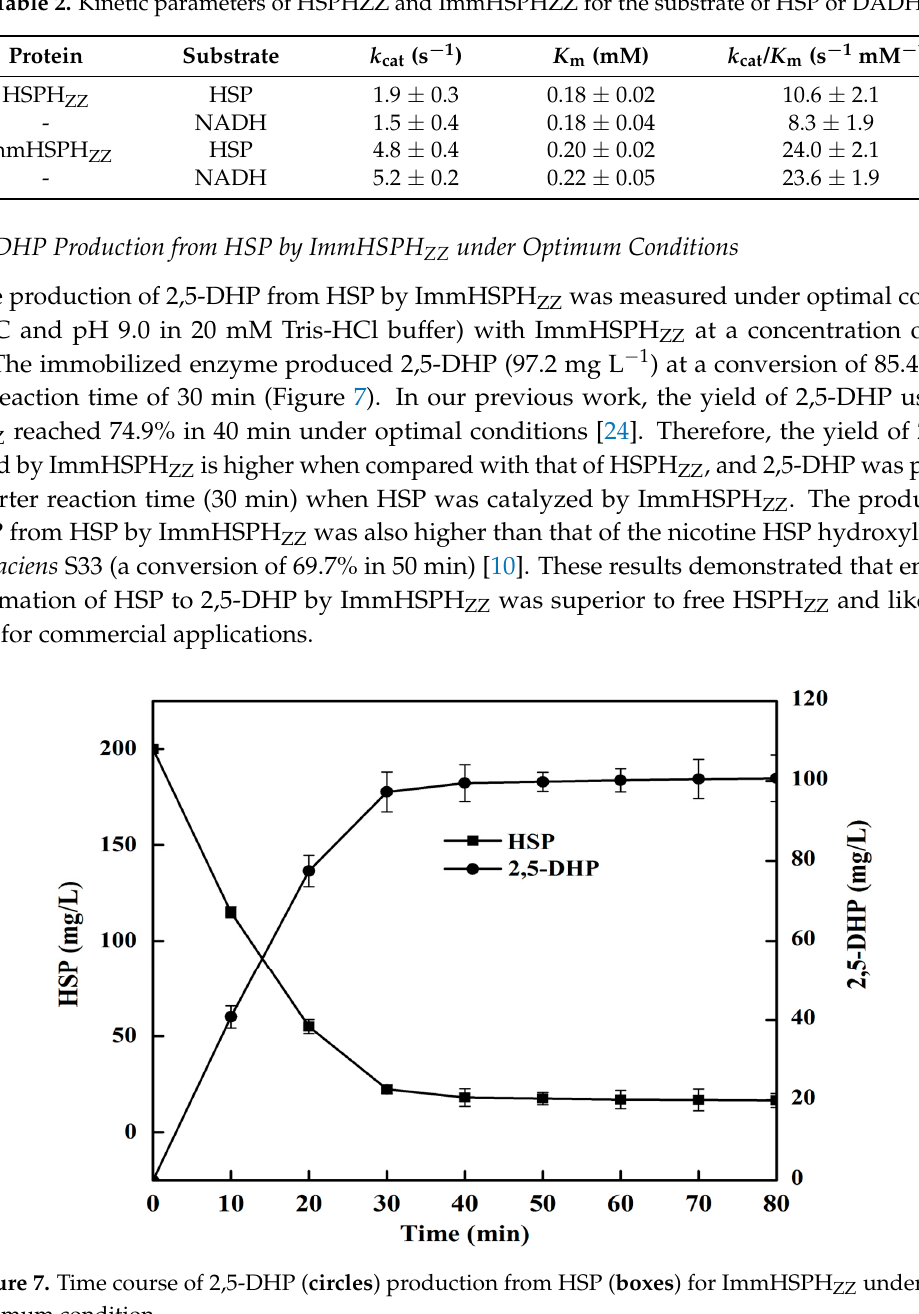
Table 2. Kinetic parameters of HSPHZZ and ImmHSPHZZ for the substrate of HSP or DADH.